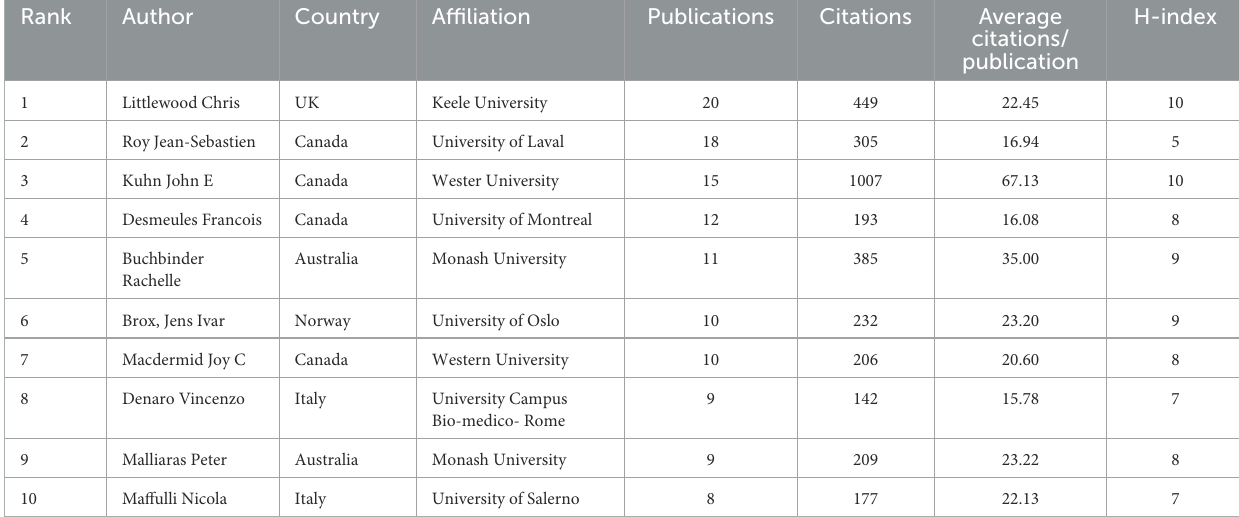
TABLE 5 Top 10 contributive authors with publications on the rehabilitation of